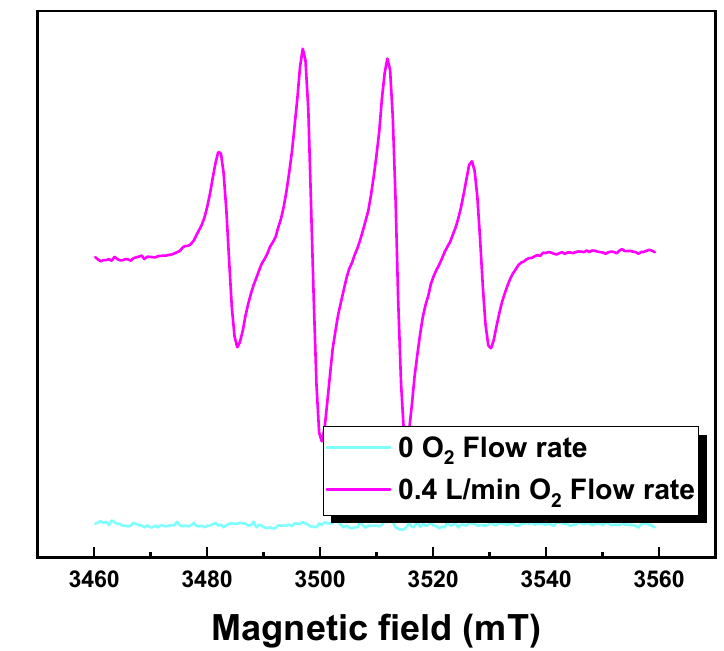
Figure 9. ESR tests of · OH during the electrochemical oxidation leaching process.